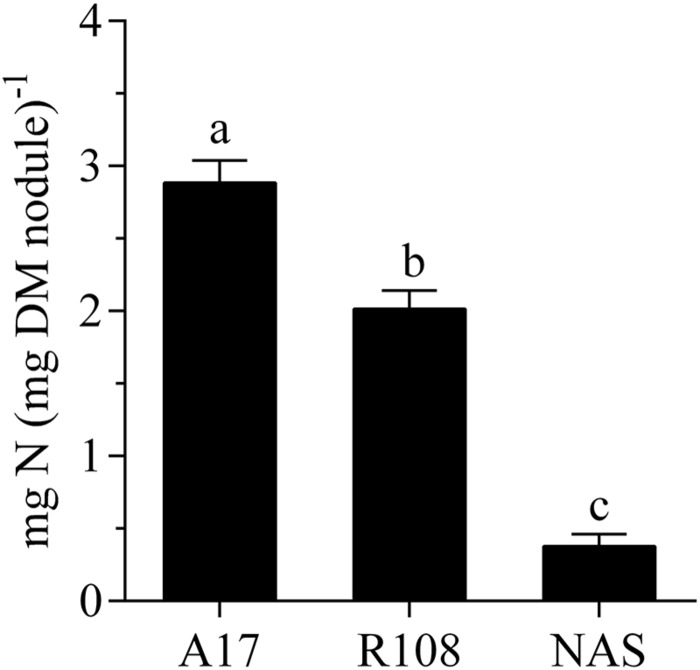
Specific nitrogen fixation of nodules of A 17 and R108 wild type plants and a Tnt1-Mt-mutant carrying an insert in the cds of Medtr1g084050 (nicotianamine synthase-like protein). The data were obtained from a continuous measurement of nodule H2 evolution (ANA) over a 24 h period and a point measurement of H2 evolution in an Ar/O2 mixture (79/21, v/v) at 10 am. Data are means of six independent biological replicates. Error bars represent standard errors. Different letters indicate a significant difference (Tukey’s test; p < 0.05).